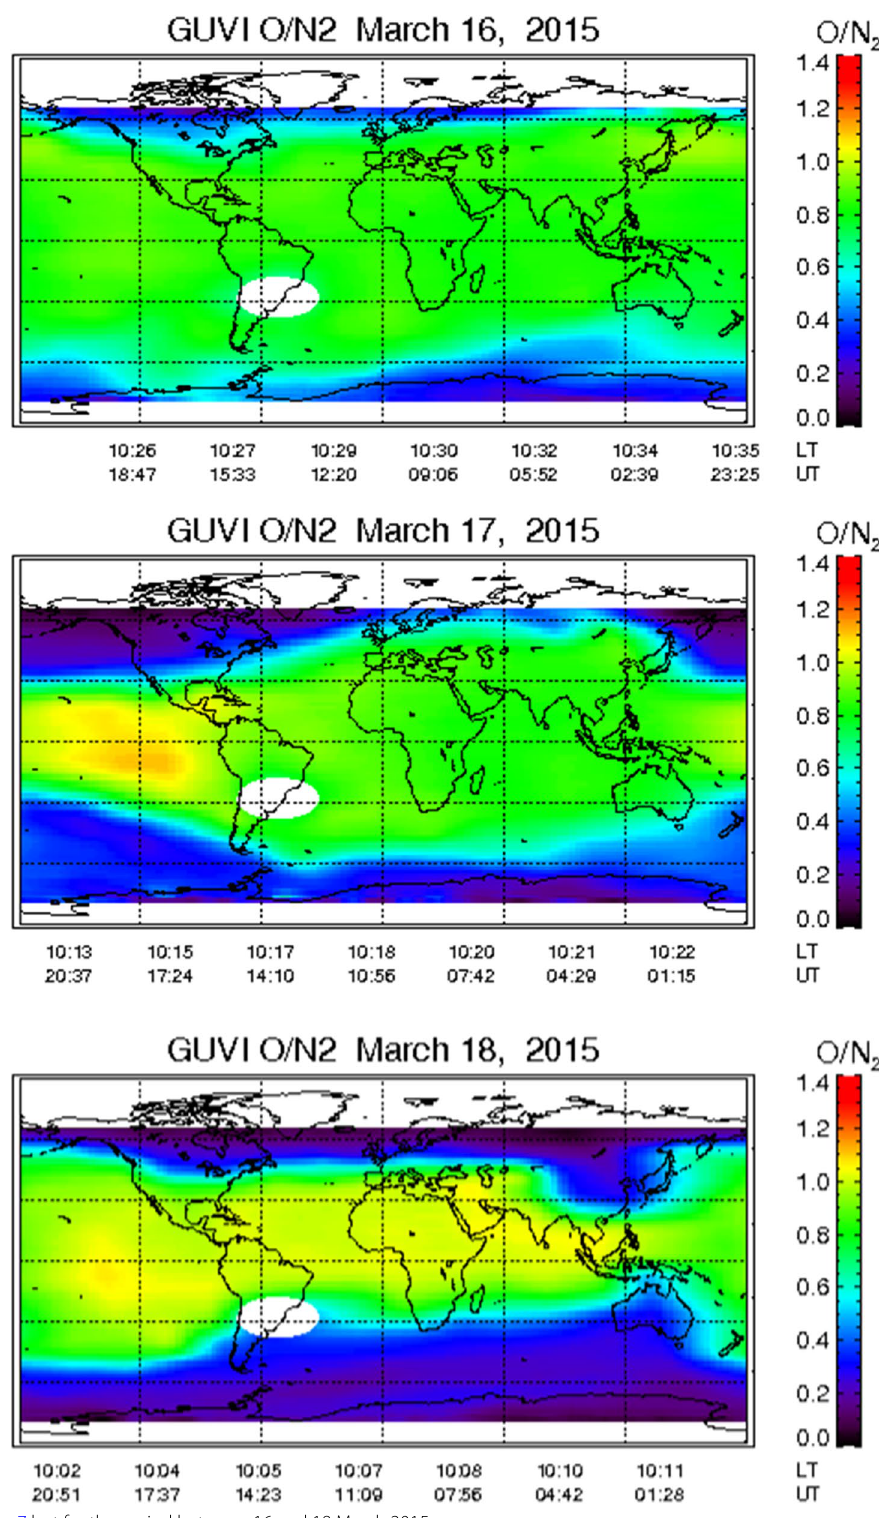
Fig. 8 Same as Fig. 7 but for the period between 16 and 18 March